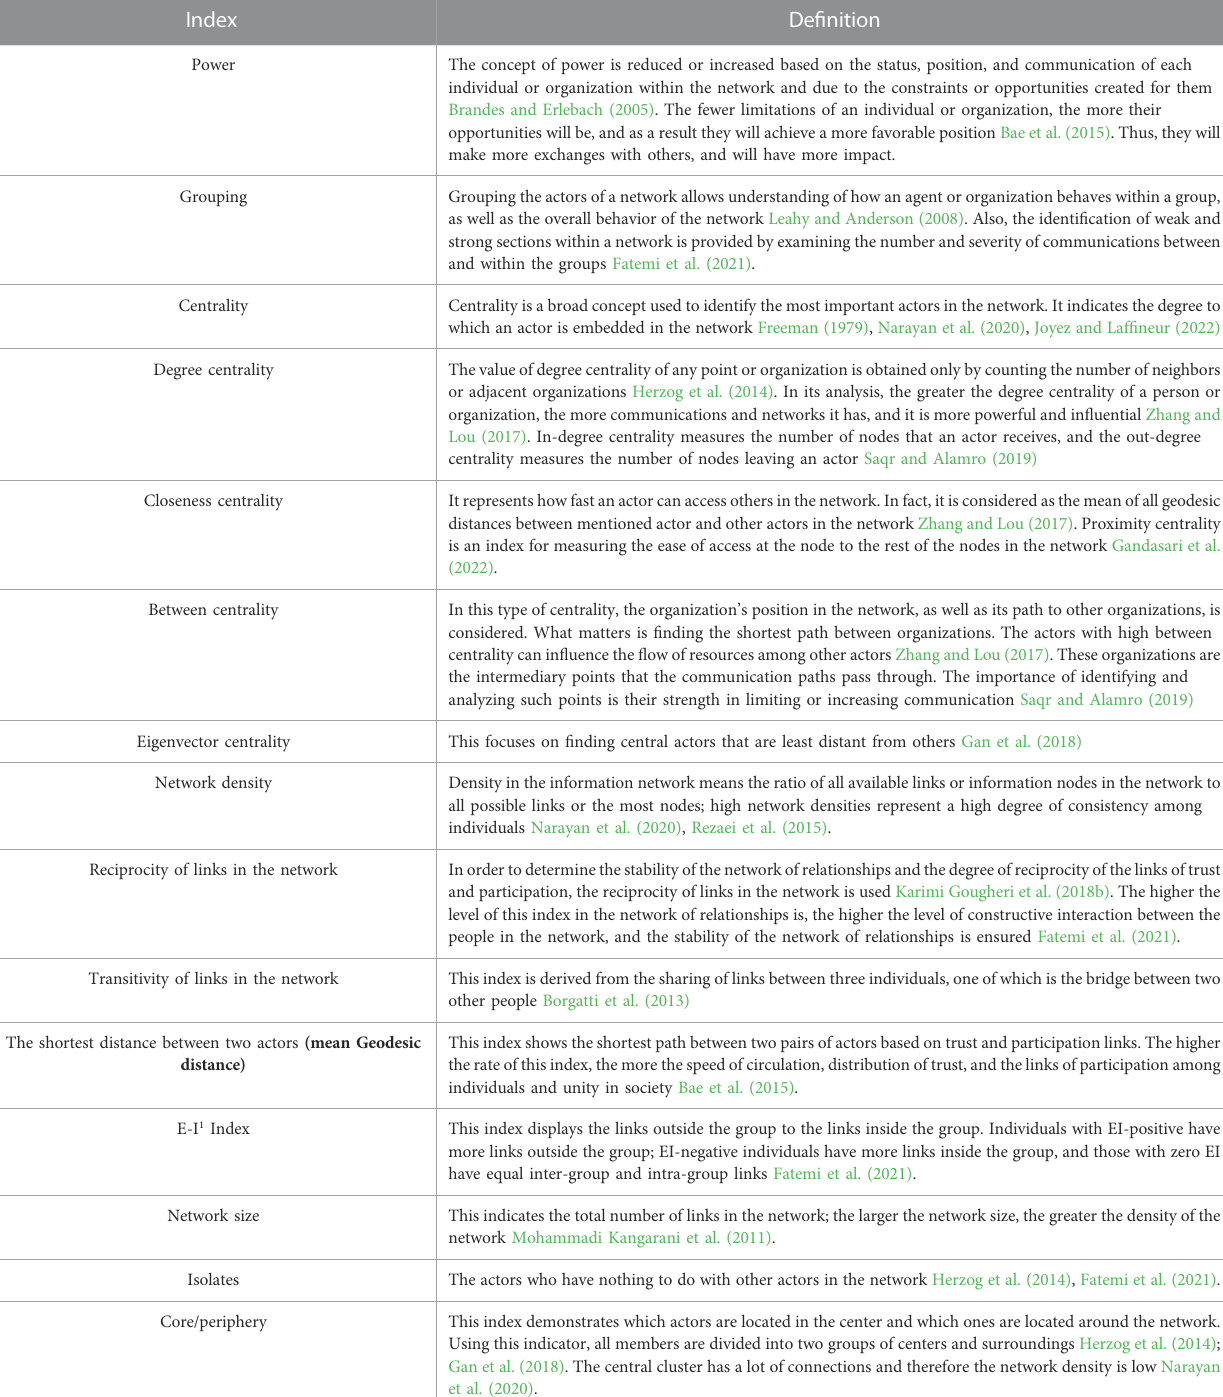
TABLE 1 Introduction of social network analysis